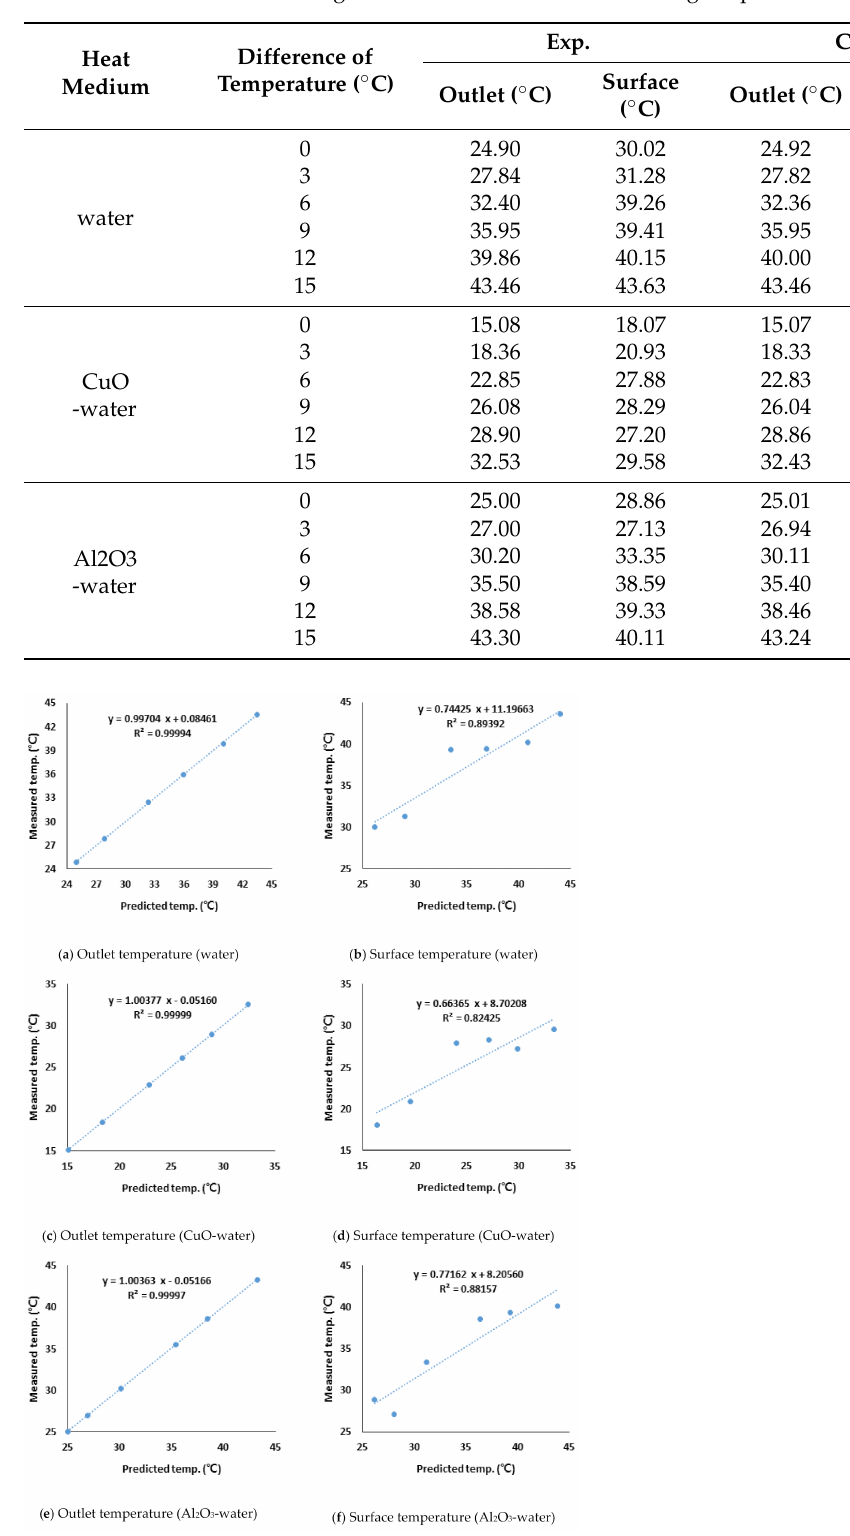
Table 8. Predicted values through CFD and measured values through experiment.